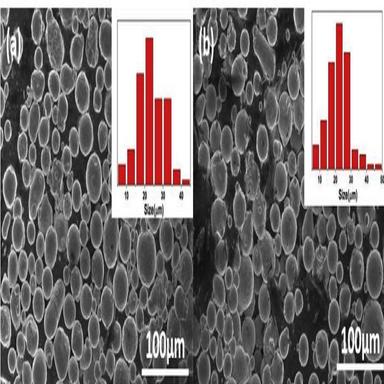
Micrographs of 316SS (a) and IN718 (b) as-fabricated precursor powder and their size distribution.